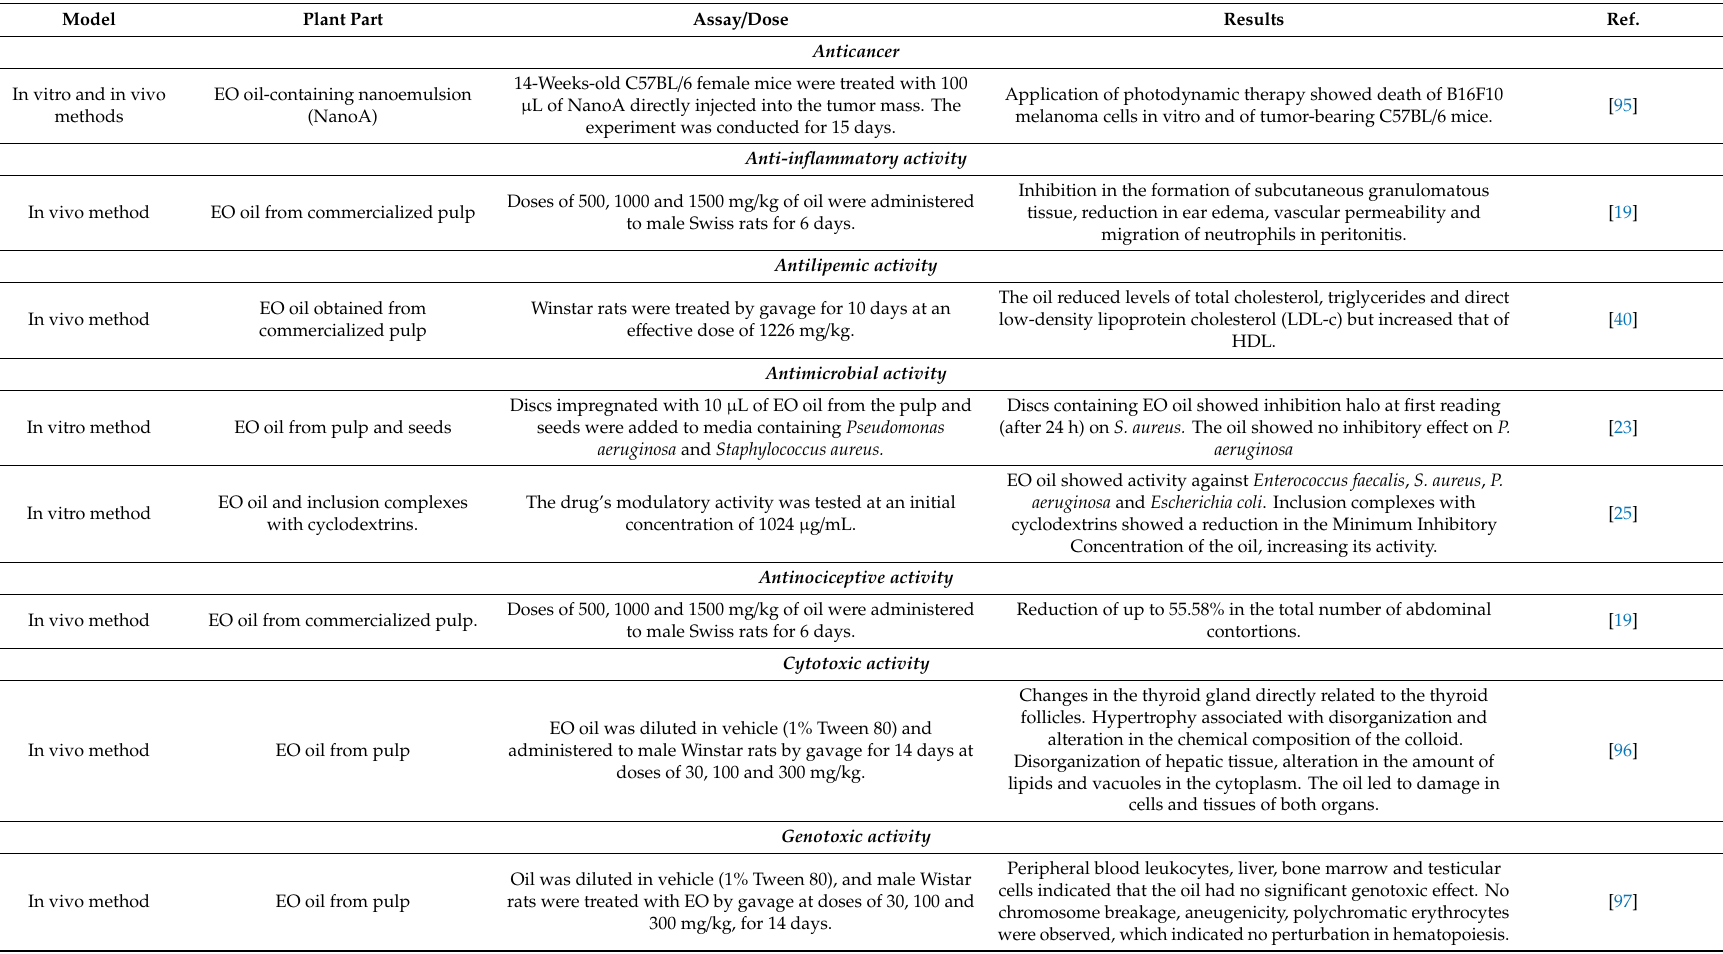
Table 3. In vitro and in vivo studies reporting the e ff ect of Euterpe oleracea Mart.